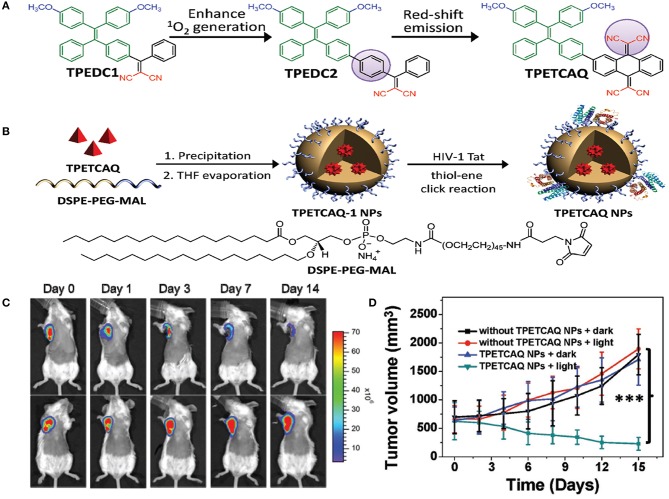
(A) Design of TPETCAQ. (B) Synthesis of TPETCAQ-1 NPs and TPETCAQ NPs. (C) Time-dependent bioluminescent 4T1-luc tumor imaging of mice after intratumoral administration of TPETCAQ NPs (30 μL, 1 mg mL−1 for TPETCAQ, top panel) or saline (bottom panel) with light irradiation (300 mW cm−2, 5 min) at 1 h post-injection. (D) Tumor volume measurement for different groups of mice. ***P < 0.001.